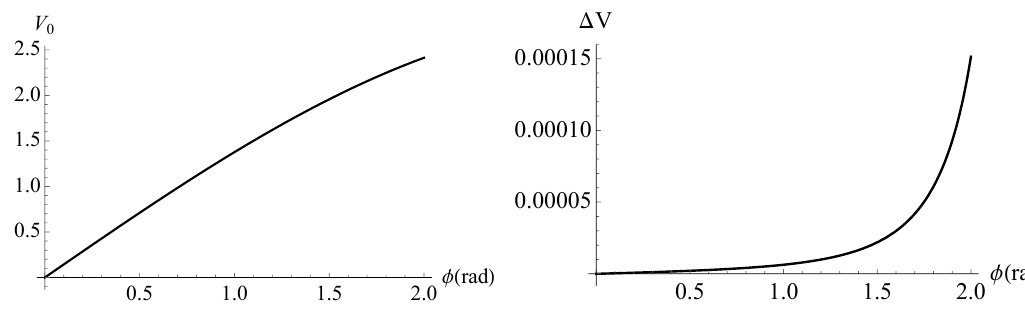
Figure 4 . Left: the uncorrected potential V 0 as a function of (cid:30) . The string worldsheet shrinks as (cid:30) ! 0, so we have V 0 ( (cid:30) = 0) = 0. Right: the 1 =N energy correction (3.10) for ( N; ~ T ) = (456 ; 0 : 02).